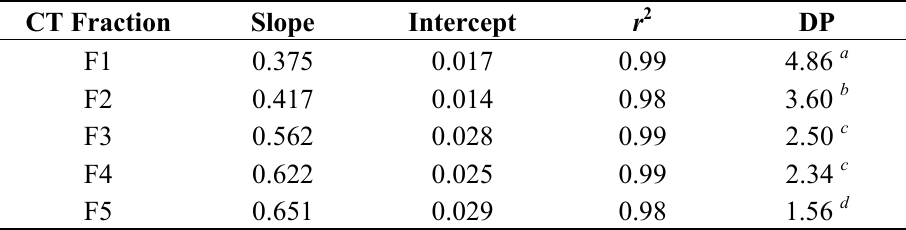
Table 2. Estimated DP of CT fractions from LLR by the modified vanillin assay and linear regression statistics of the absorption spectrum